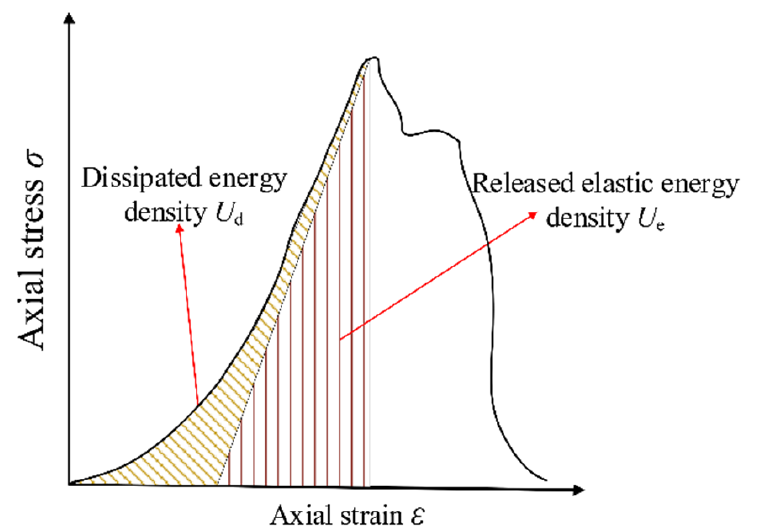
Figure 8. The relationship between the released elastic energy density and the dissipated energy density.